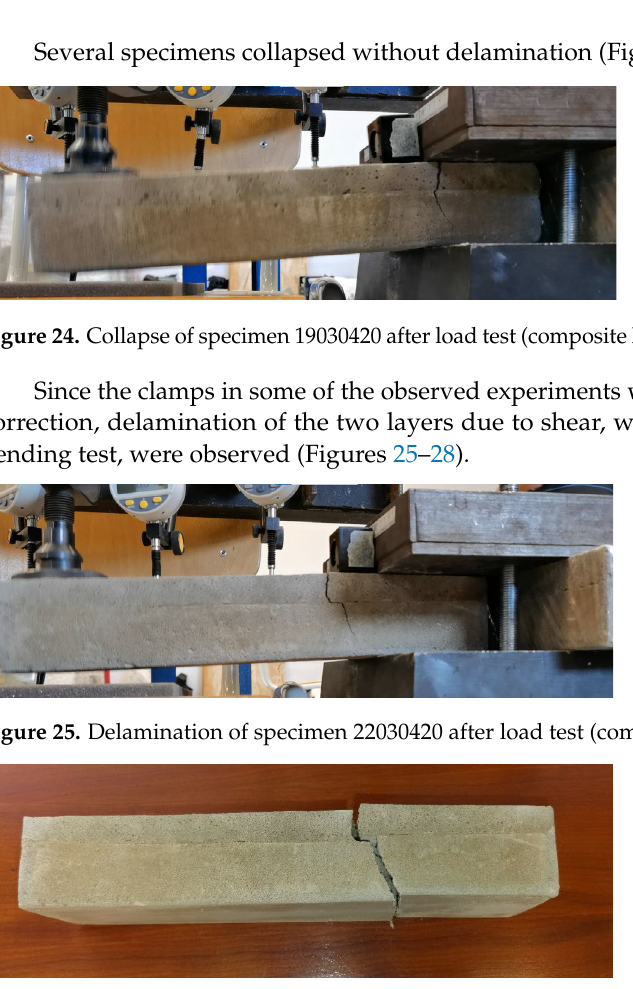
Figure 26. Detail of delamination- specimen 22030420. Figure 27. Delamination of specimen 24030420 after load test (composite FC and CC).